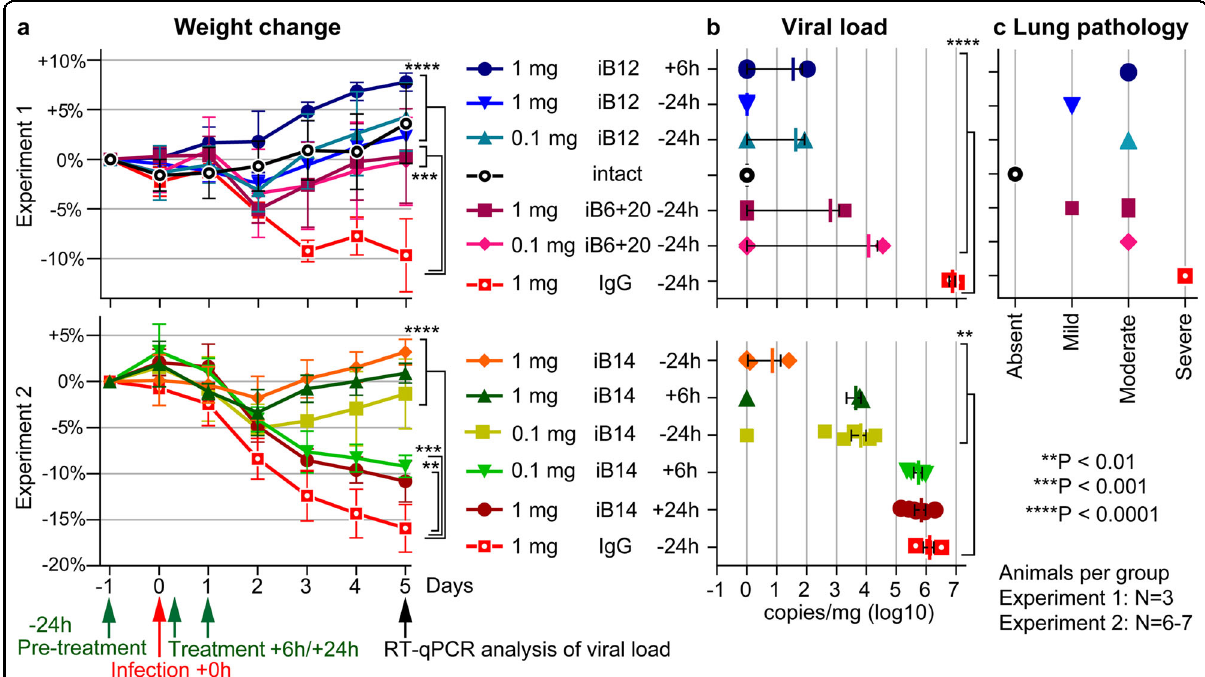
Fig. 6 Ef fi cacy of iB12, iB14, and iB6 + iB20 cocktail in treatment and prophylaxis of SARS-CoV-2 infection in a hamster model. In a prophylactic regimen, antibodies were administered i/p 1 day before infection at a dose of 1 or 0.1 mg/animal (i.e., ~10 or 1 mg/kg weight). Control animals received 1 mg of total human IgG. In the therapeutic regimen, iB12 antibody (1 mg/animal) was given 6 h following the viral challenge (Experiment 1), whereas iB14 antibody was injected either 6 h (0.1 or 1 mg/animal) or 24 h (1 mg/animal) following the viral challenge (Experiment 2). Intact animals formed a separate control group. Animals were sacri fi ced on day 5 following infection. Lungs were weighted and used for RT-qPCR quanti fi cation of the viral load. a Relative weight dynamics in the prophylaxis and treatment groups following administration of iB nAbs or control total human IgG. Error bars represent means ± SD. b Impact of iB nAbs on the levels of viral transcripts in hamster lungs (RT-qPCR with RdRp primers). RT-qPCR with E gene-speci fi c primers produced very similar results (not shown). Animals with strongly reduced human nAb titers in the blood were considered as outliers due to the technical error of nAb injection and were excluded from the analysis. Error bars represent means ± SEM. c Lung pathology scores for hamster lungs at 5 dpi (Supplementary Fig.